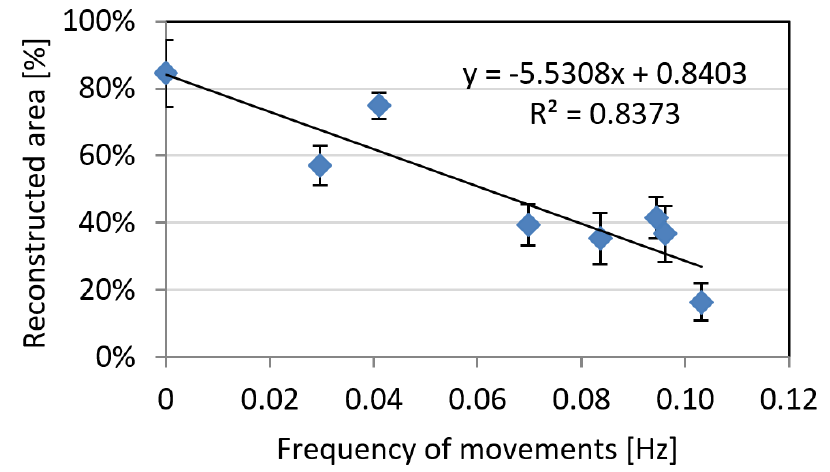
Figure 7. The reconstructed area rate as a function of average estimated animal movements’ frequency. Error bars represent standard deviation on three different reconstructions.